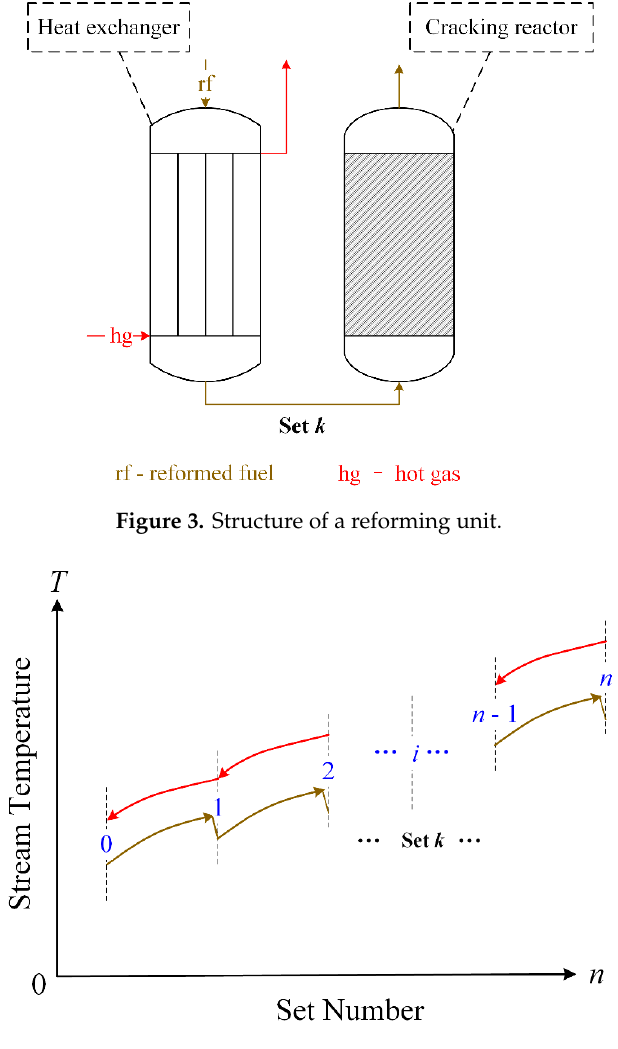
Figure 4. Fluid temperature along the stream.